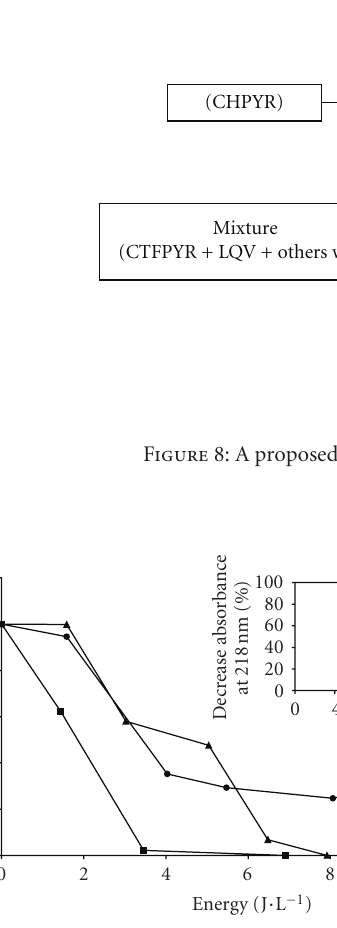
Figure 9: Relative absorbance of the phototreated Endosulfan contaminated water as a function of the specific energy. The H 2 O 2 is varied from: ( • ) 8mM, ( (cid:2) ) 12mM to ( (cid:3) ) 16mM. The insert is percentage of relative degradation of the Endosulfan (monitored at 218 nm) when 6 × 10 3 J · L − 1 energy is accumulated in the photoreactor for the three H 2 O 2 values